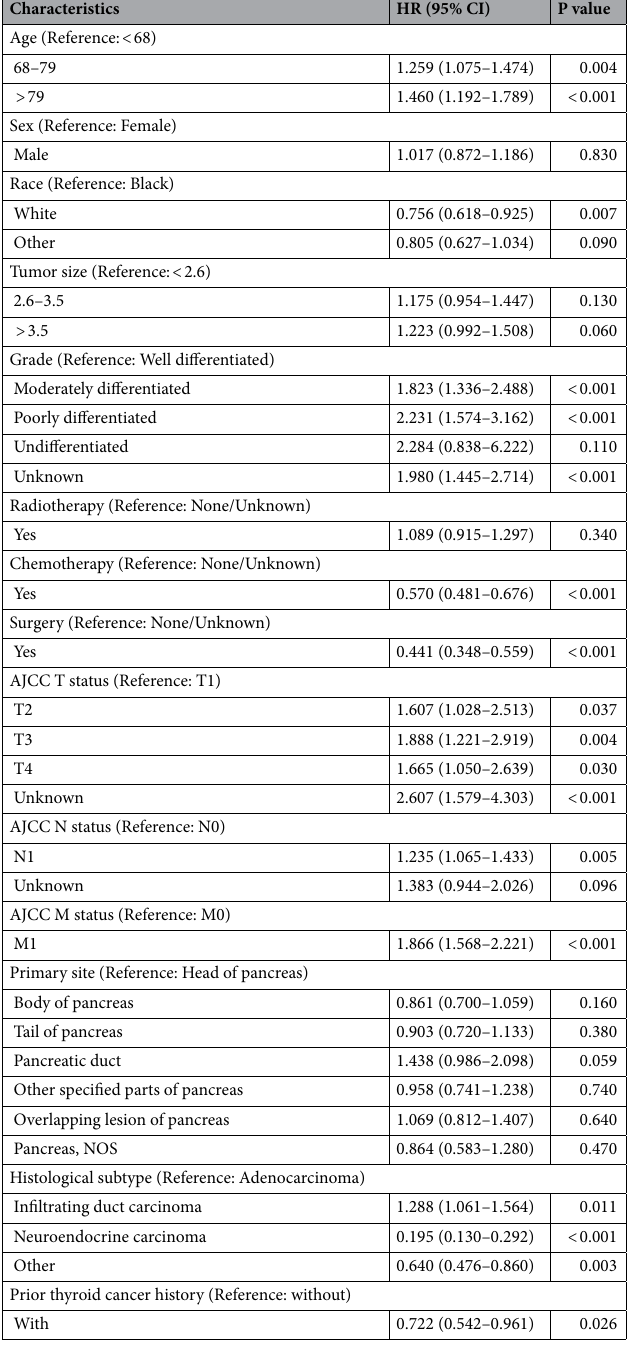
Table 3. Multivariate analysis of CSS in PC patients. CSS cancer-specific survival, AJCC American Joint Commission on Cancer(7th), SEER the surveillance, epidemiology, and end results, HR hazard ratio, CI confidence